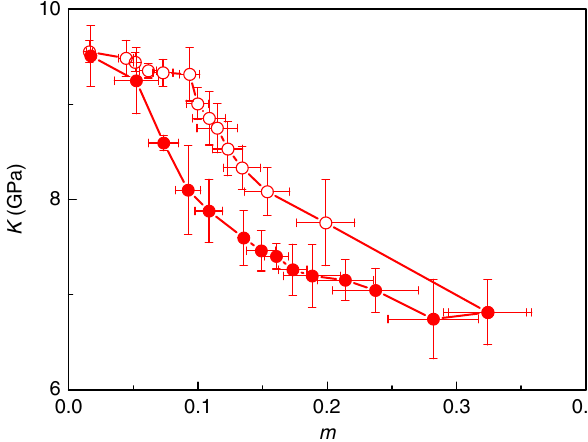
Fig. 5 Mechanical properties of cellulose upon sorption. Bulk modulus K as a function of moisture content m upon water sorption in cellulose at T = 300 K. The open and closed symbols correspond to adsorption and desorption, respectively. The insert shows that the bulk modulus K , plotted as a function of the number of cellulose – cellulose hydrogen bonds HB CC , is hysteresis-free. The error bar is de fi ned as the standard deviation (s.d.) of the three